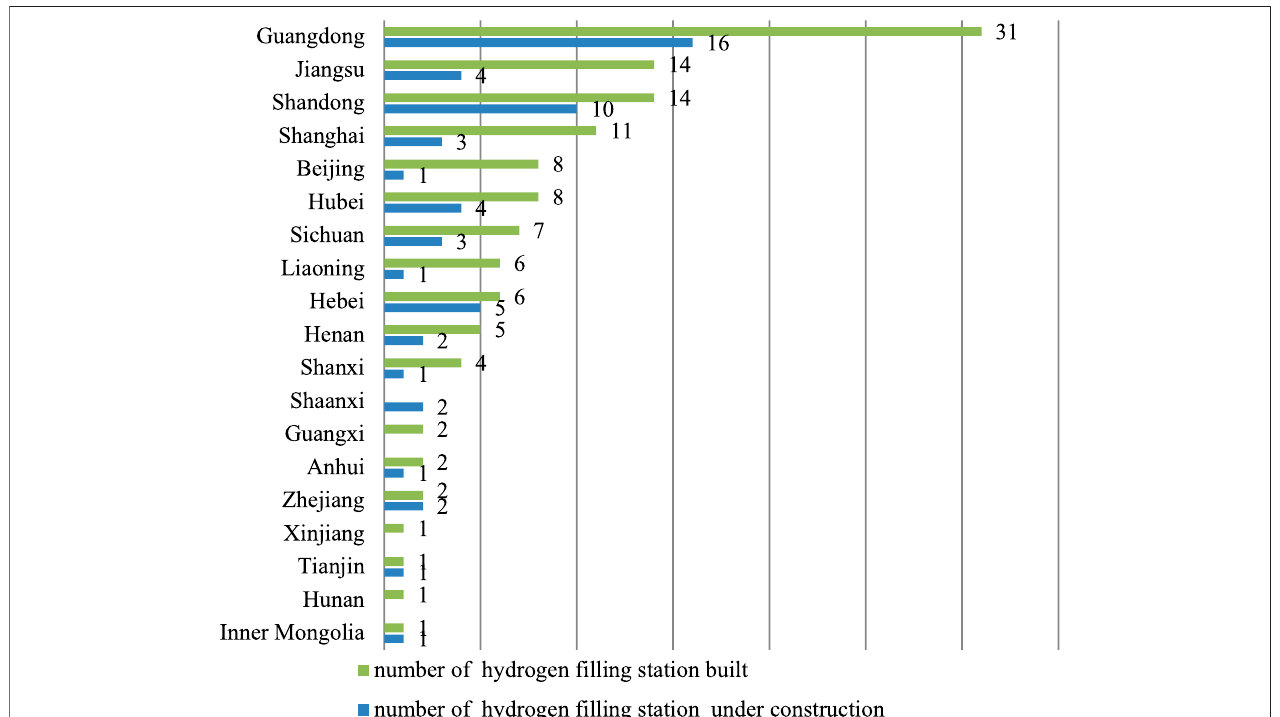
FIGURE2| Thenumberofhydrogen- fi llingstationsbuiltandunderconstructionofChina ’ sprovincesby2020.Datasource:GGII.Note:Forsimplifying, “ Province ” in this article includes municipalities directly under the Central Government.